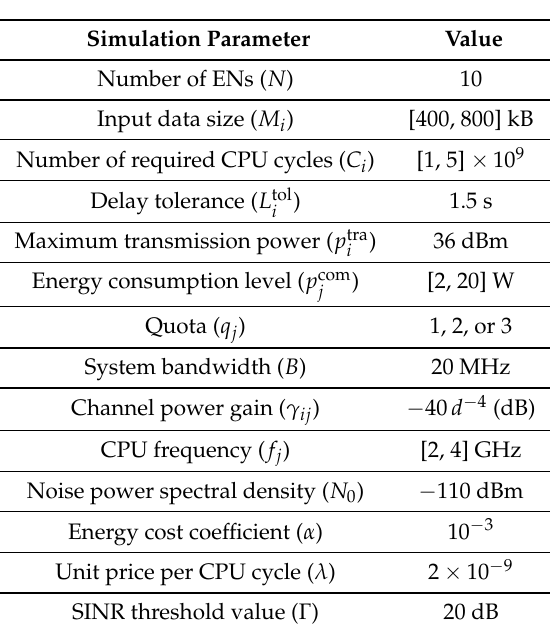
Table 1. Simulation